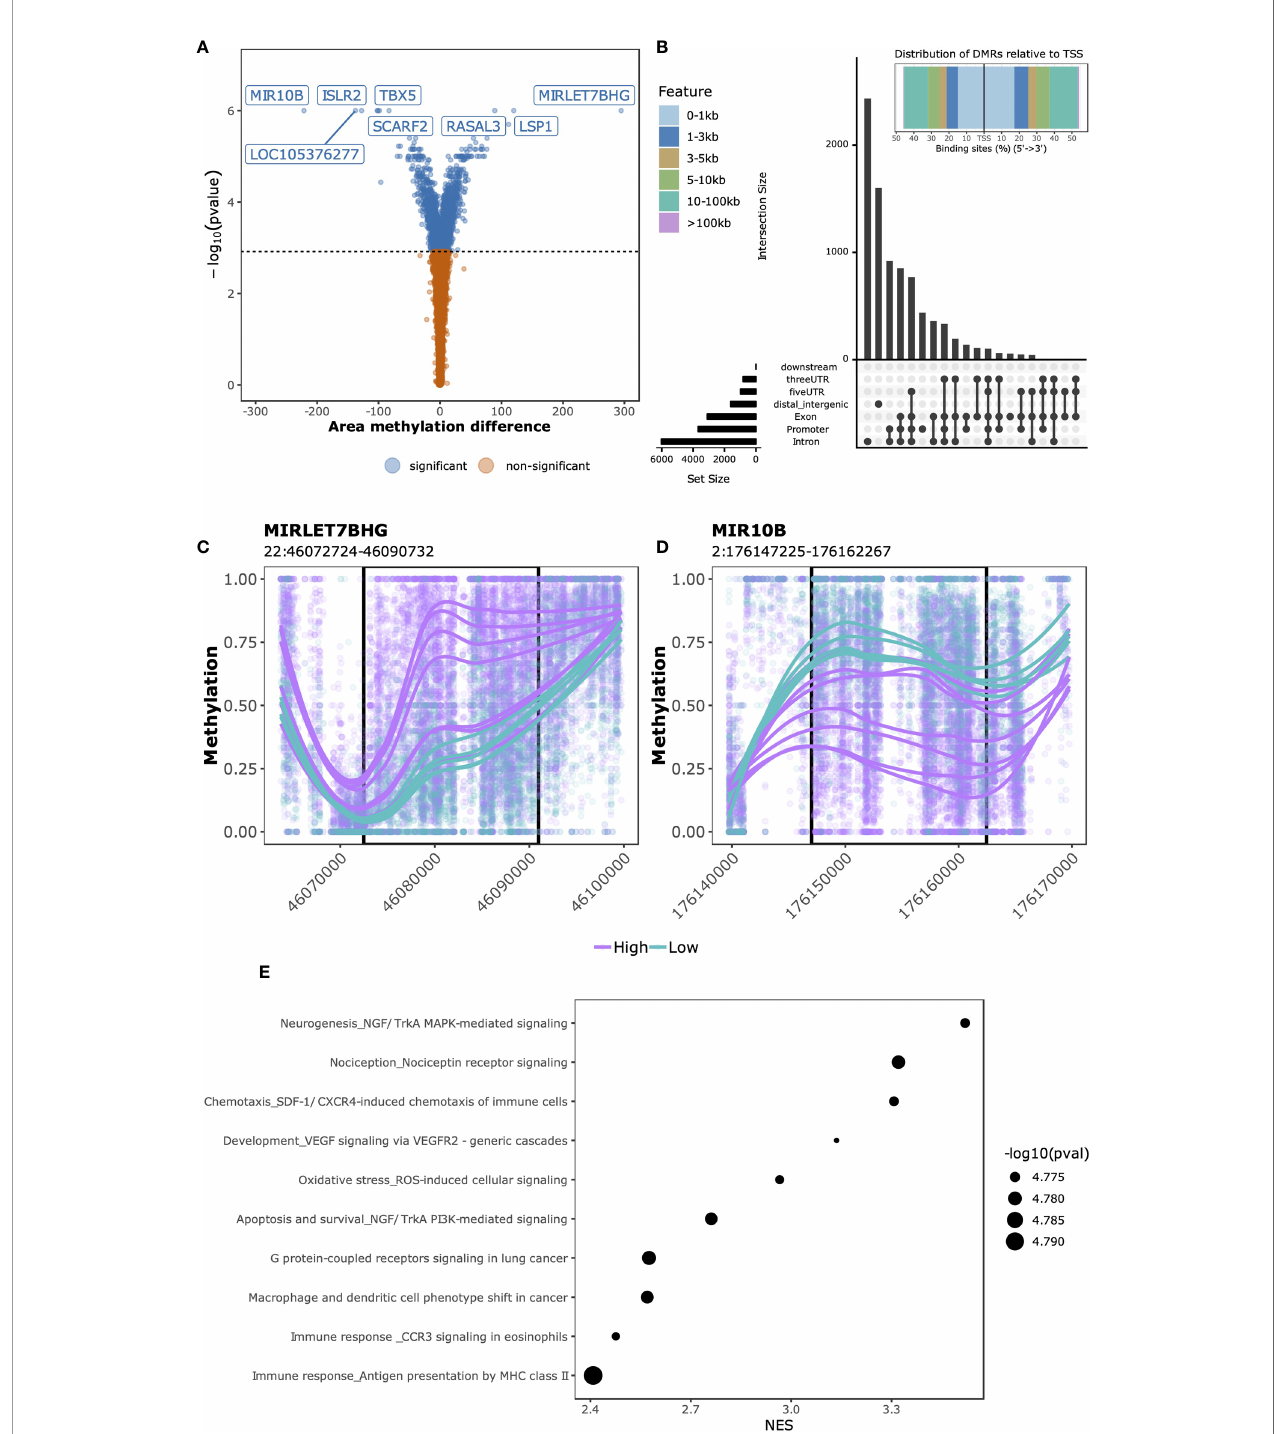
FIGURE 2 | SJC66 high versus SJC66 low differential methylation analysis. (A) Volcano plots depicting the -log 10 ( p -value) on the y-axis relative to the difference in % methylation when comparing the SJC66 high with SJC66 low samples on the x-axis. Colours represent the non-signi fi cant (orange) and signi fi cant regions (blue). Statistical signi fi cance is further depicted by a dashed horizontal line. (B) At the top: distribution of the DMRs relative to the transcription start site (TSS) and at the bottom: upset plot indicating the distribution of the DMRs across the different genetic features. (C, D) DMRs found at genomic co-ordinates (C) 22:46,072,724- 46,090,732 and (D) 2:176,147,225-176,162,267 are located in the promoters of MIRLET7BHG and MIR10B, respectively. DNA methylation is visualized as the percentage methylation (y-axis) with a smoothed trendline per sample. (E) The 10 most enriched MetaCore gene sets associated to the promoter-bound DMRs. Tick marks represent gene ranks relative to the direction of the methylation effect and is summarized by the normalized expression score